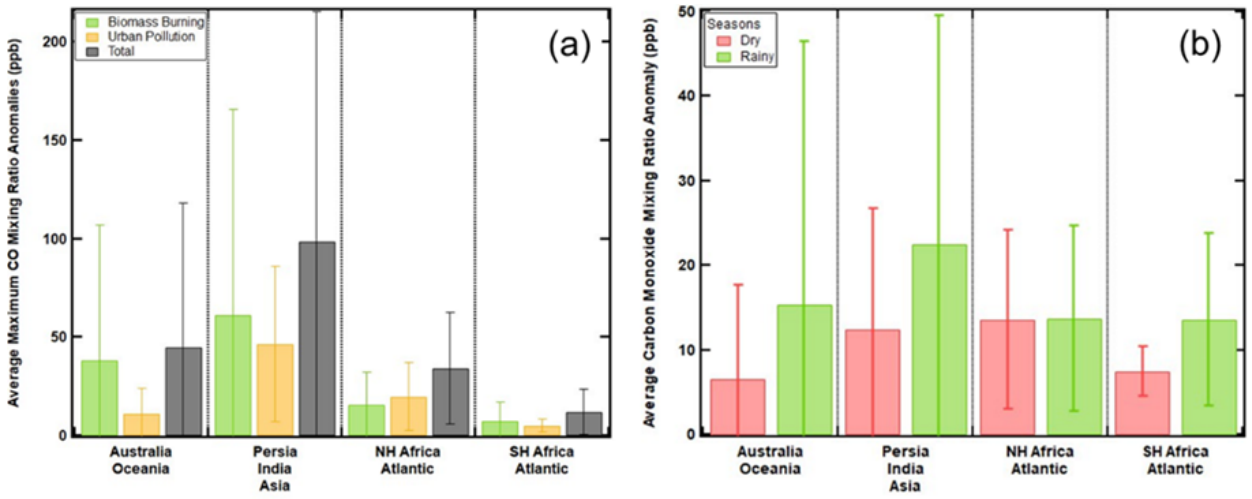
Figure 4. The average CO anomaly as a function of geographical region and (a) source of CO and (b) season of the year. The vertical lines are standard deviations about the mean.